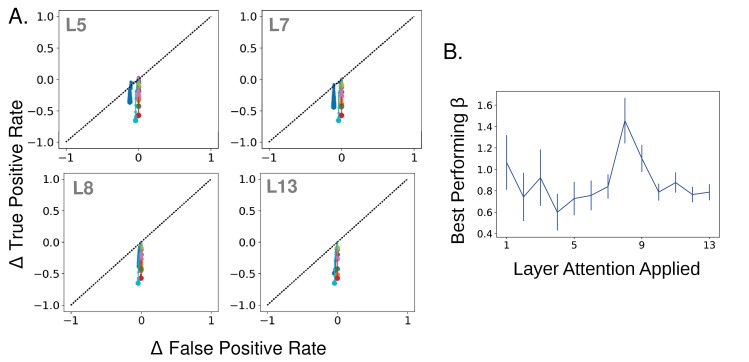
Negatively applying attention and best-performing strengths.(A) Effect of strength increase in true and false positive rate space when tuning values are negated. Negated tuning values have the same overall level of positive and negative modulation but in the opposite direction of tuning for a given category. Plot same as in Figure 4A. Layer attention applied at indicated in gray. Attention applied in this way decreases true positives, and to a lesser extent false positives (the initial false positive rate when no attention is applied is very low). (B) Mean best performing strength (β value; using regular non-negated attention) across categories as a function of the layer attention is applied at, according to merged images task. Errorbars ± S.E.M.